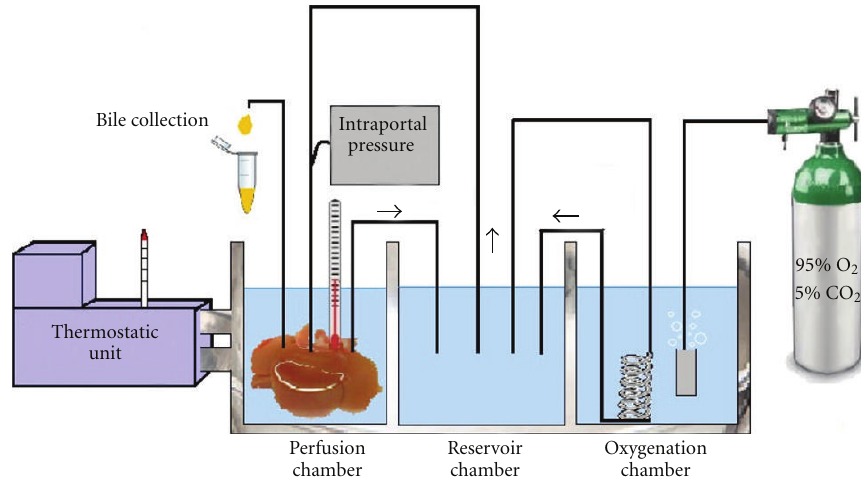
Figure 5: Illustrative representation of machine